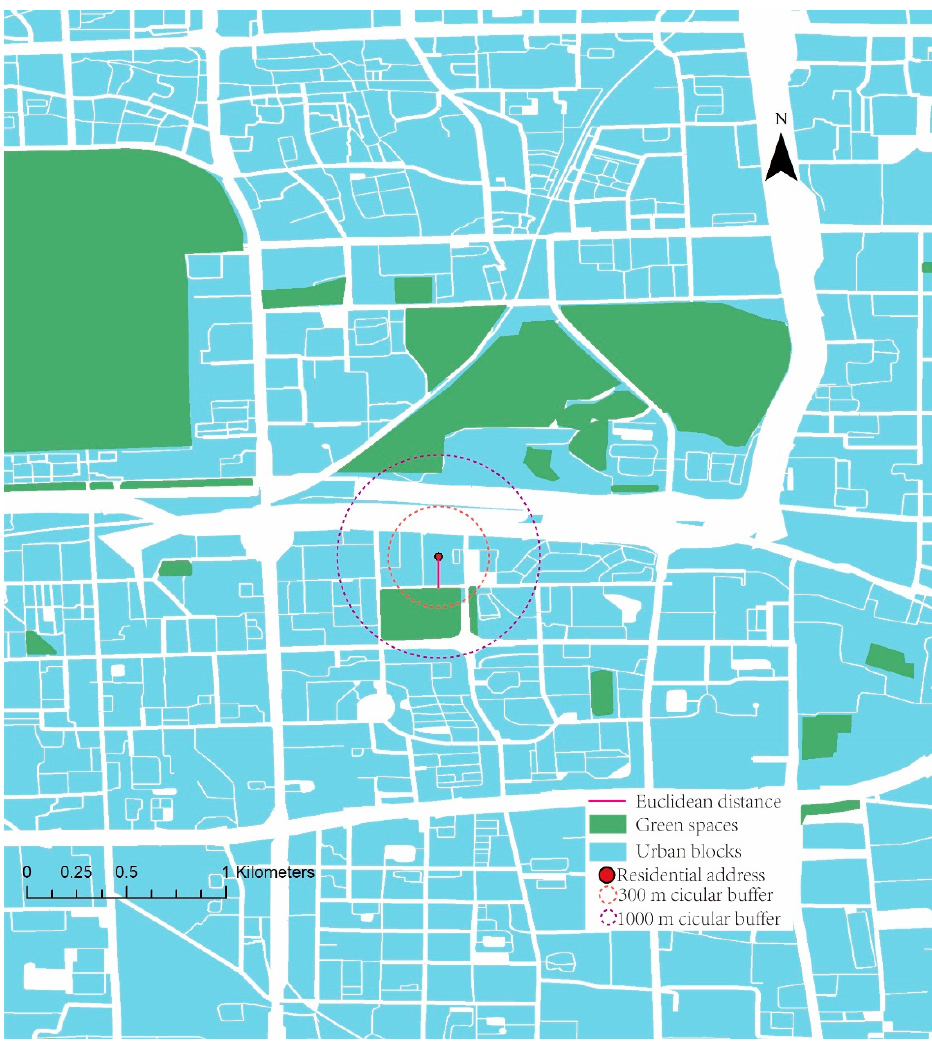
Figure 3. The definition of distance buffers with green spaces around the residences.